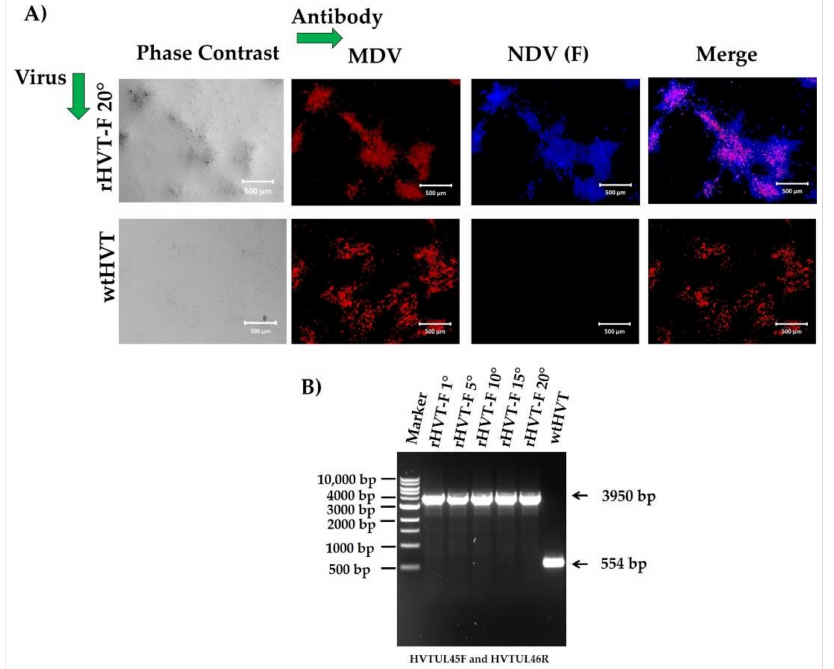
Figure 4. Stability of the rHVT-F virus. ( A ) The F protein expression was detected by indirect im- munofluorescence assay (IFA) in the rHVT-F virus-infected CEF cells at 20th passage by staining with anti-NDV chicken serum, followed by Goat anti-chicken IgY H&L Alexa Fluor ® 405 (blue fluorescence). HVT was detected with a mouse antibody against Marek’s disease virus (MDV) (B149M), followed by goat anti-mouse IgG H&L Alexa Fluor ® 594 (red fluorescence) and visualized by fluorescence and bright-field microscopy: 50 × magnification, all scale bars represent 500 µ m. ( B ) The genetic stability of rHVT-F virus was detected from infected CEF cells, so viral deoxyribonu- cleic acid (DNA) was extracted and analyzed by PCR with primers HVT UL45F and HVT UL46R at passage 1, 5, 10, 15, and 20. The primer sequences and direction are shown in Figure 1A. The molecular sizes are indicated to the left of the gel in